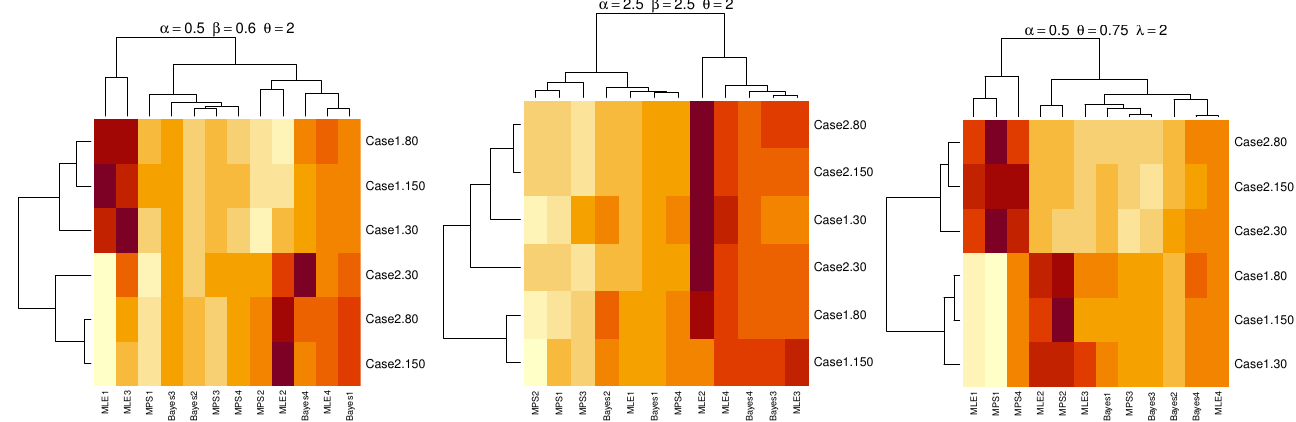
Figure 3. Heatmaps of RB for parameters under different estimation